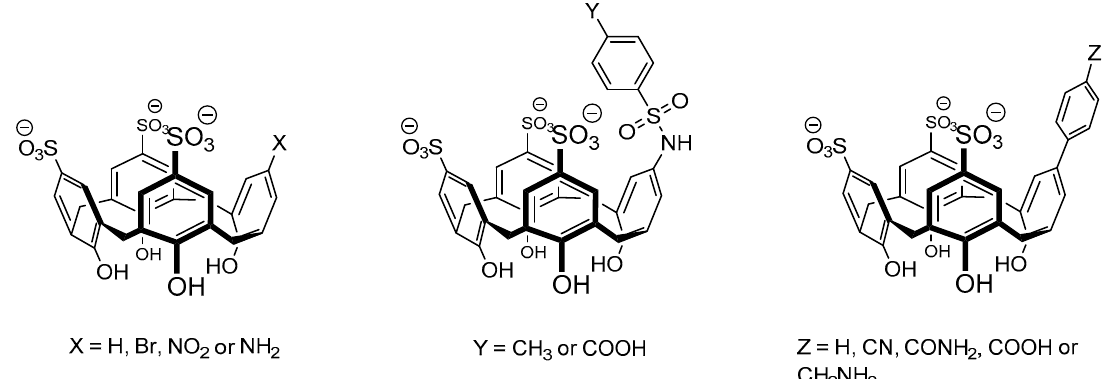
Figure 4. Structures of the upper rim monofunctionalized sulfonatocalix[4]arene receptors synthesized by Hof, where the structure with an added aromatic ring with Z = H, corresponds to SC4-Ar [90].